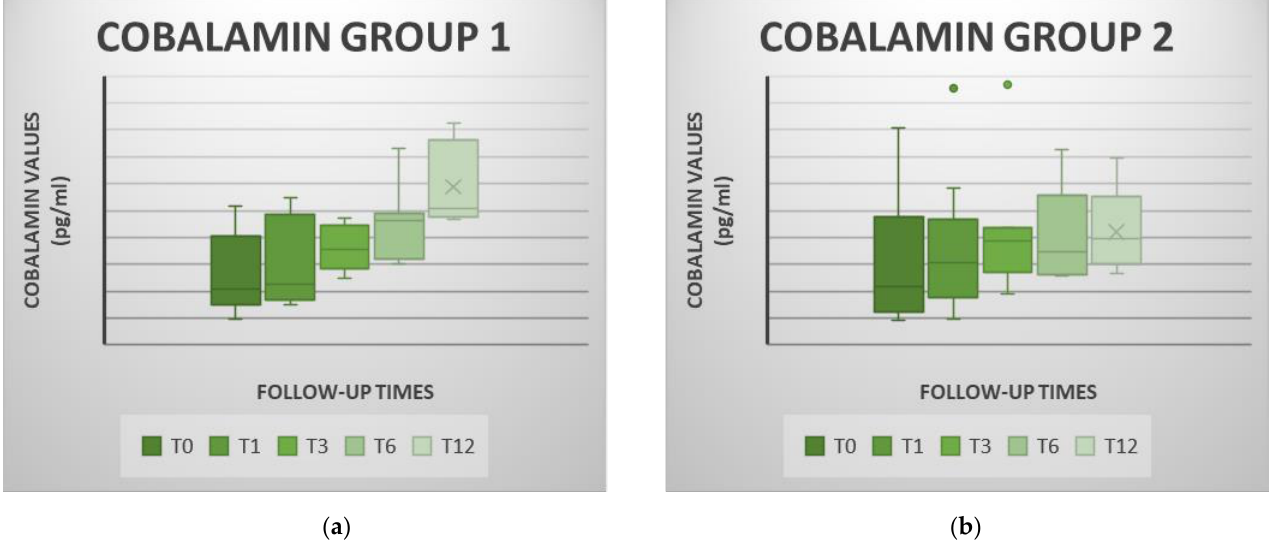
Figure 5. Cobalamin concentration values observed at each control point for the cell therapy group (MSC group; figure ( a )) and for the combined prednisone and stem cells group (P-MSC group; figure ( b )). Statistically significant differences were noted between both groups at T12 ( p < 0.05). In both groups, cobalamin increases over the periodic reviews, showing the MSC-group (group 1) the steepest increase. Box and Whisker Diagram: the graphs show the median (line inside the box), 25th and 75th percentiles (box) and minimum and maximum values (whiskers).